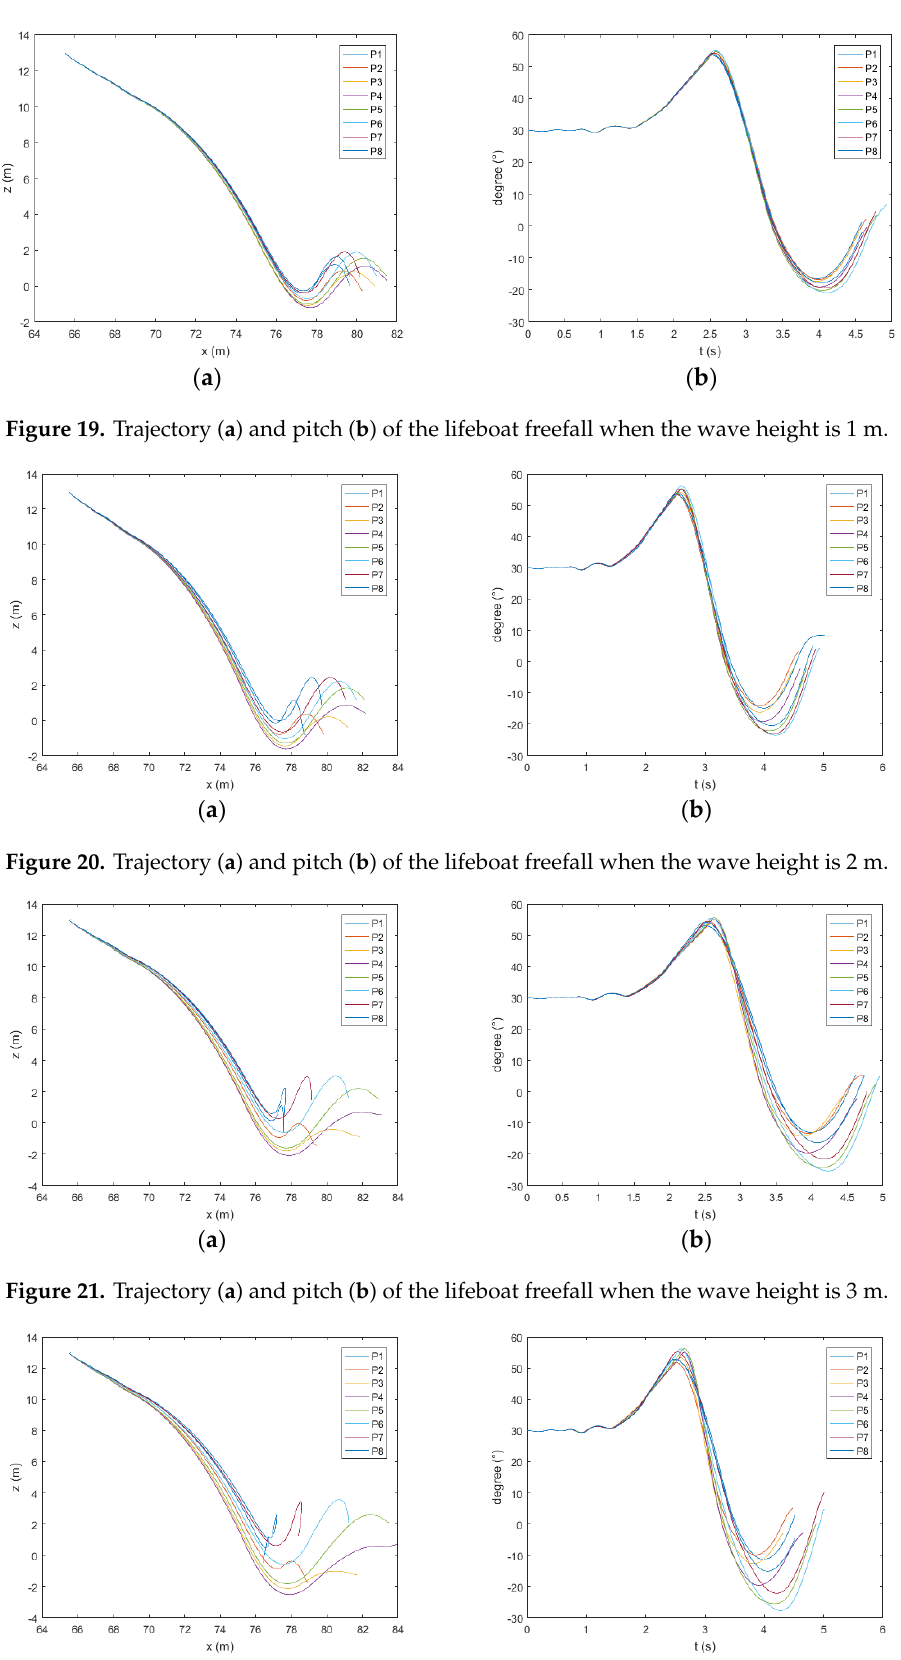
( a ) ( b ) Figure 23. Trajectory ( a ) and pitch ( b ) of the lifeboat freefall when the wave height is 5 m. ( a ) ( b )